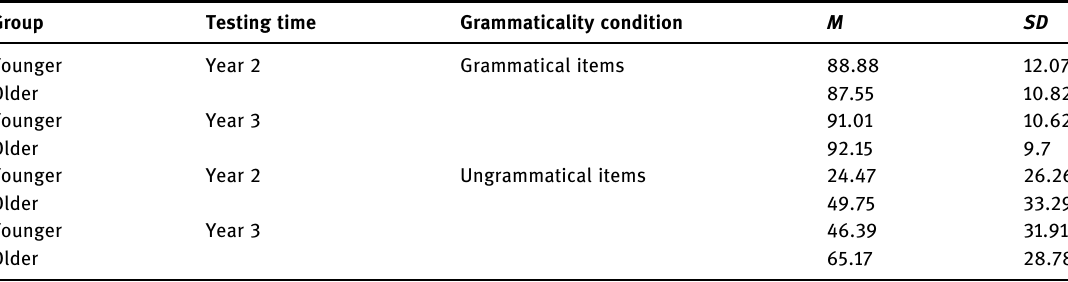
Table 3: Accuracy rates per testing times and grammaticality condition